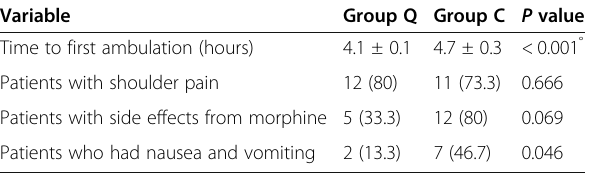
Table 6 Comparison between both groups